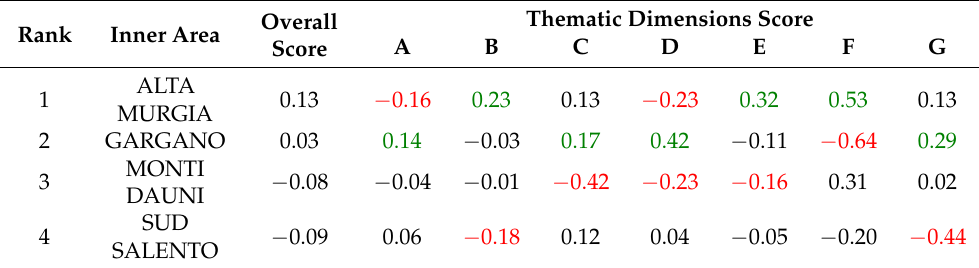
Table 1. The overall development score of the inner areas and the score for each thematic dimension (net outranking flow, ϕ ). The best and the worst scores for each thematic dimension are highlighted in green and red,